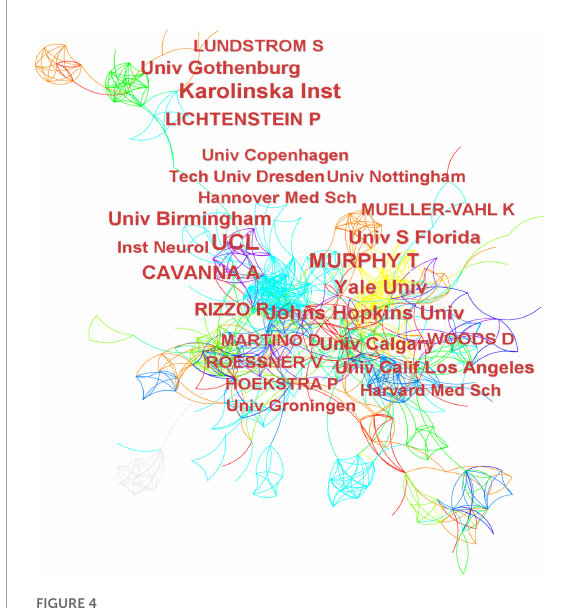
FIGURE4 Institutions cooperation and co-authors map related to Tourette Syndrome (TS) in children research from 2011 to 2021.